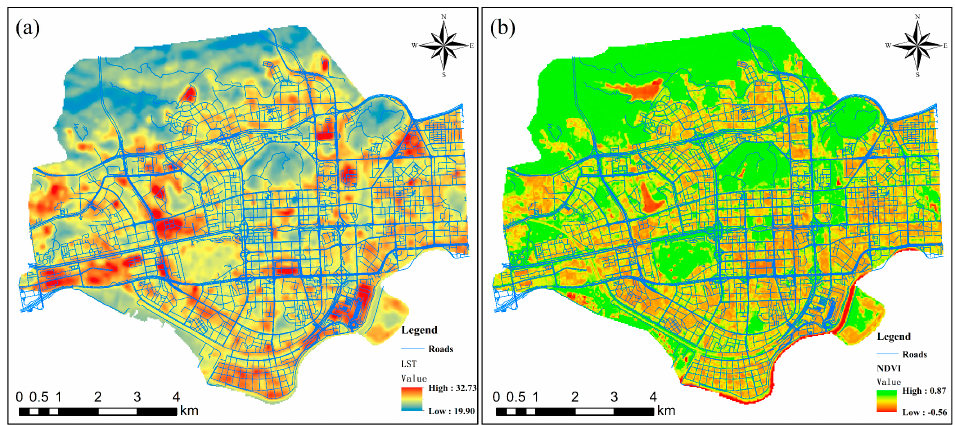
Figure 4. Mapped retrieval results of Landsat-8 remote sensing images: ( a ) LST retrieval results and ( b ) NDVI retrieval results.